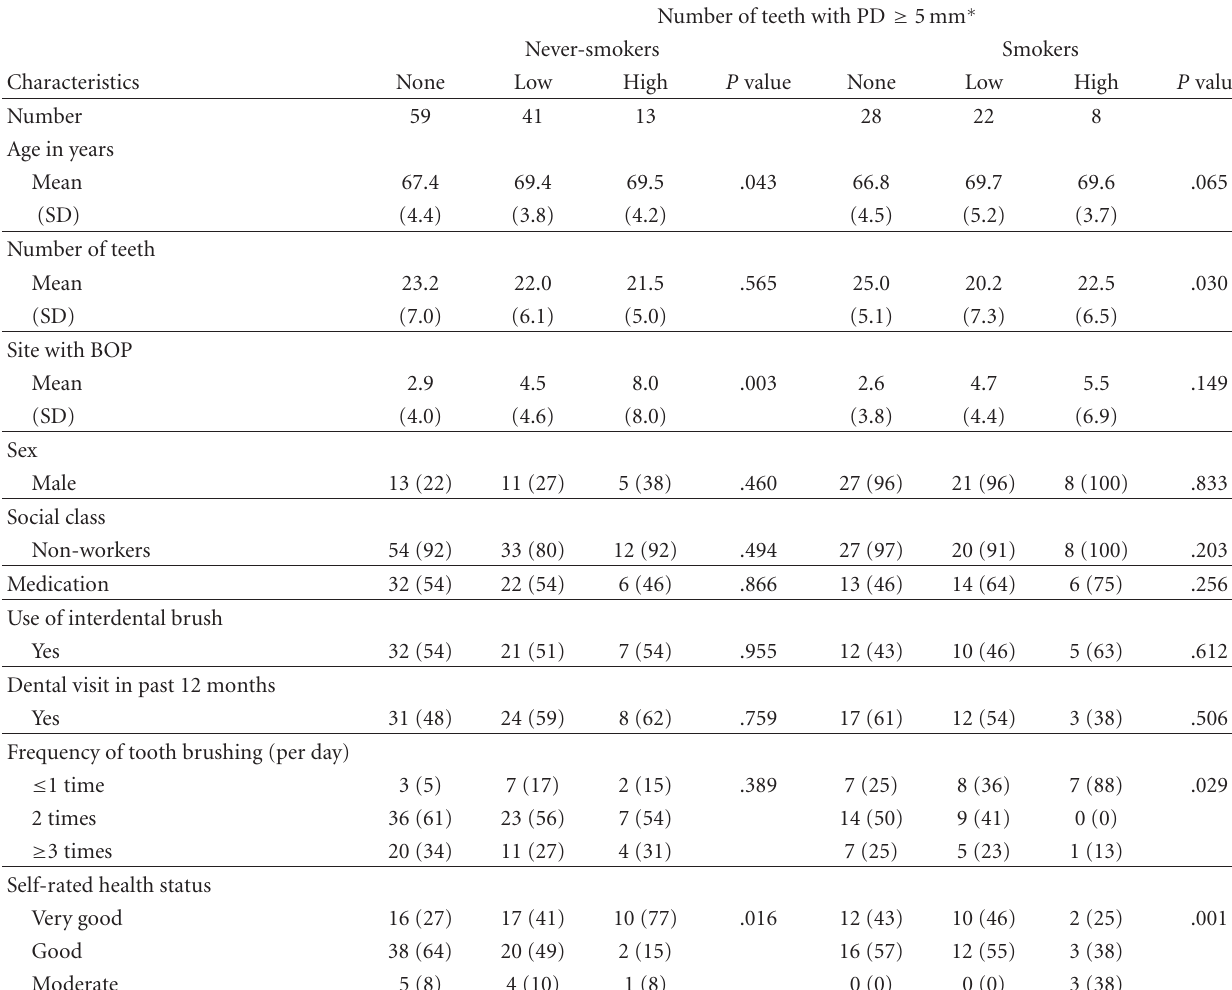
Table 1: Subject characteristics by smoking status based on PD